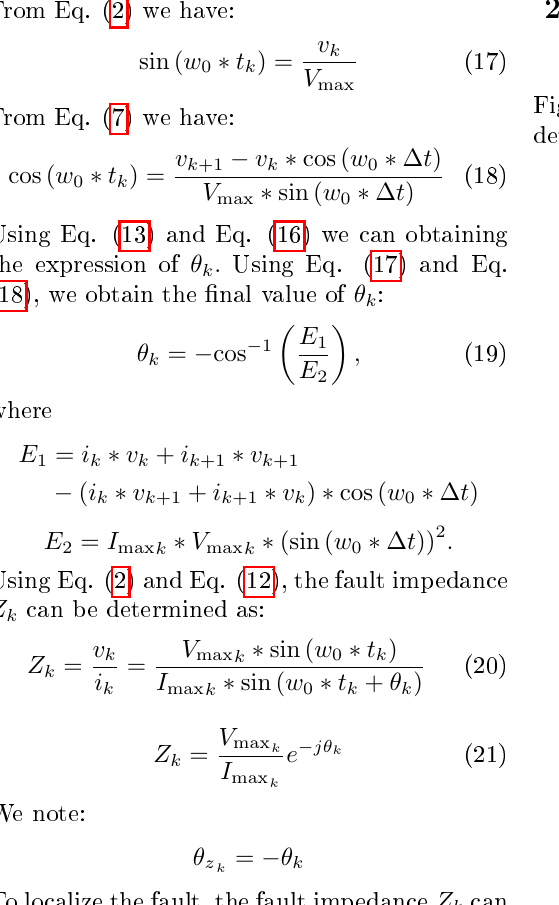
Fig. 1: The (cid:29)owchart of the methodfor fault detection and